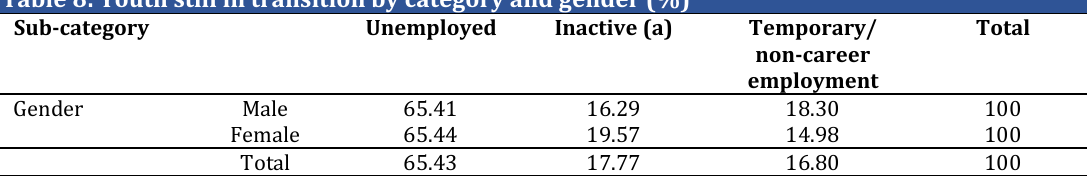
Table 8: Youth still in transition by category and gender (%) Sub-category Unemployed